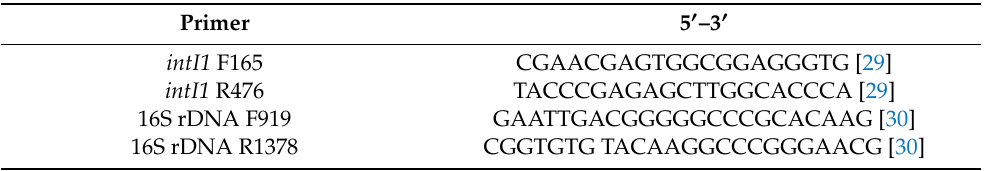
Table 2. Primers used for the detection of class 1 integron-integrase gene ( intI1 ) and 16S ribosomal DNA (16S